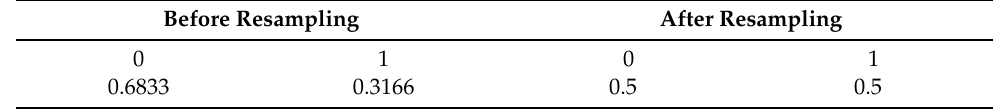
Table 1. Class distribution before and after resampling.